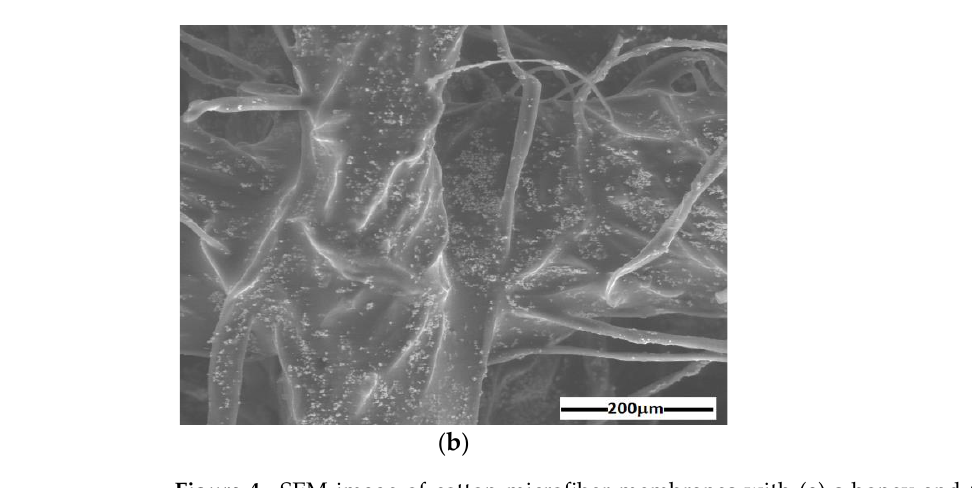
Figure 4. SEM image of cotton microfiber membranes with ( a ) s honey and ( b ) honey, CI, and silver microparticles.